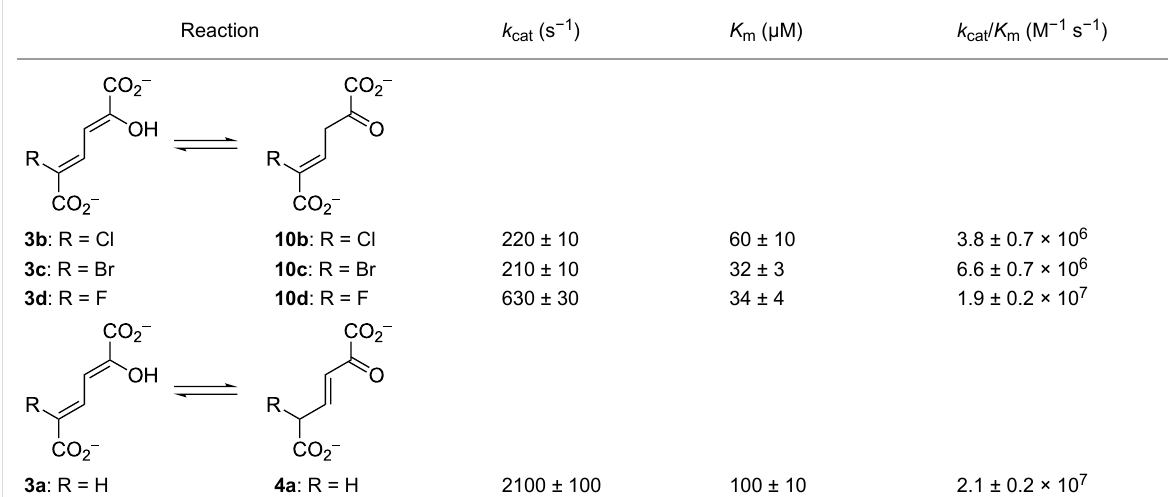
Table 1: Kinetic parameters for Pp 4-OT using 3a – d . a